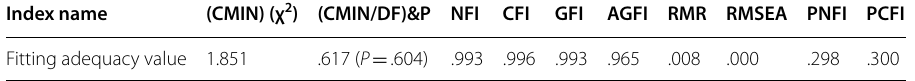
Table 8 Index of fix indices model